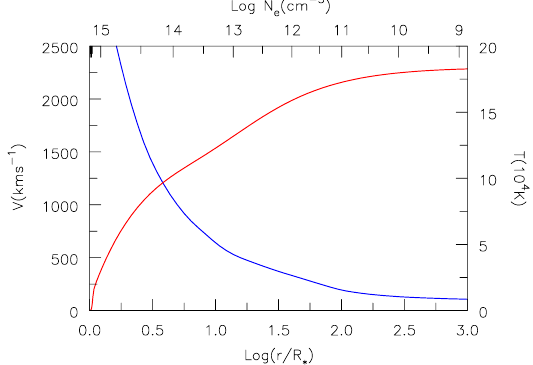
Figure 9. Illustration of the electron temperature (blue) and velocity structure (red) in the model for the WC4-type star, BAT99-9. The model has log L / L (cid:12) = 5.48, an effective temperature of 84,000K,